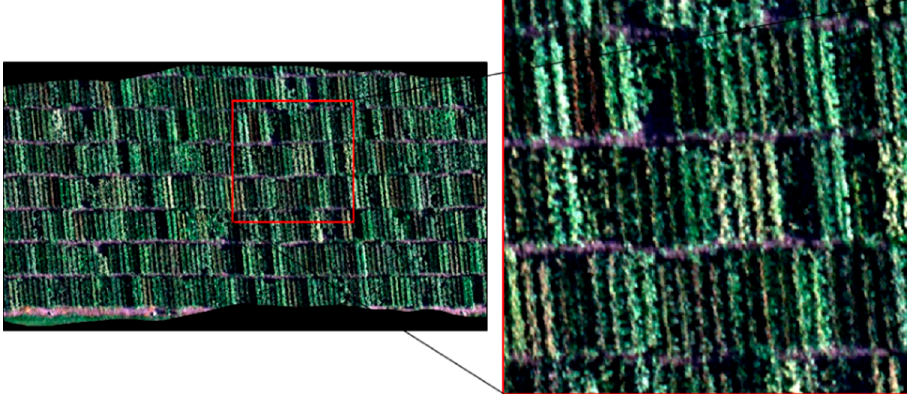
Figure 2. Portion of a partially-rectified hyperspectral orthophoto that shows a repetitive pattern within an agricultural field (RGB bands are displayed).